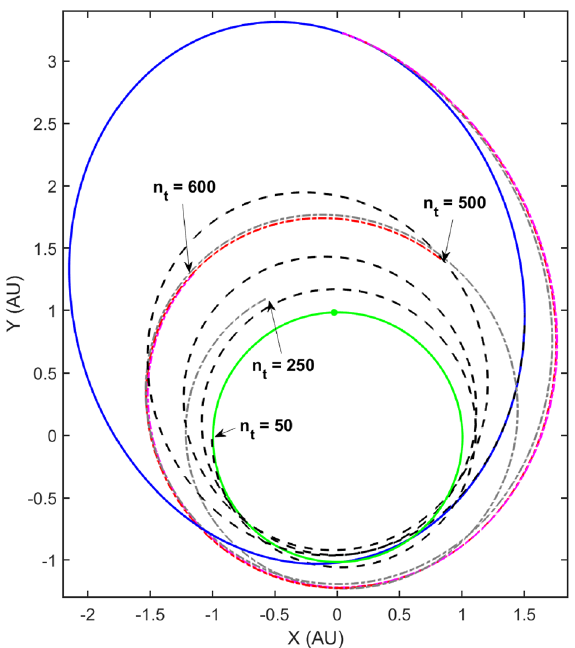
Figure 10. Independently Re-planned Trajectories starting at N t time-steps.